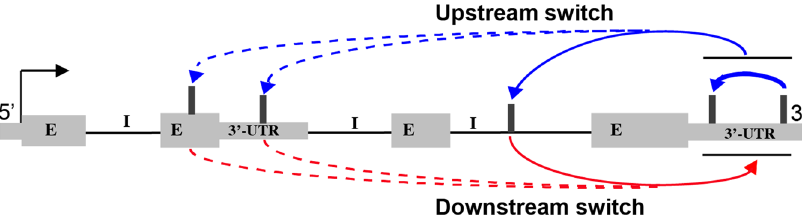
Fig. 1 Schematic representation of PAS switches. Switches in PAS utilization are shown with arrows : upstream switches are depicted in blue and downstream switches in red . An upstream switch is most often from distal 3 ′ -UTR to any internal gene regions (intron, exon, and internal 3 ′ -UTR), and a downstream switch is most often from any internal gene regions to distal 3 ′ -UTR. Switches between tandem PASs in the distal 3 ′ -UTR are also shown. The most prominent switches are depicted with continues line. PASs are depicted with vertical bars , the gene regions, exon (E), intron (I), and 3 ′ -UTR are indicated. Illustrated are the most abundant switch possibilities